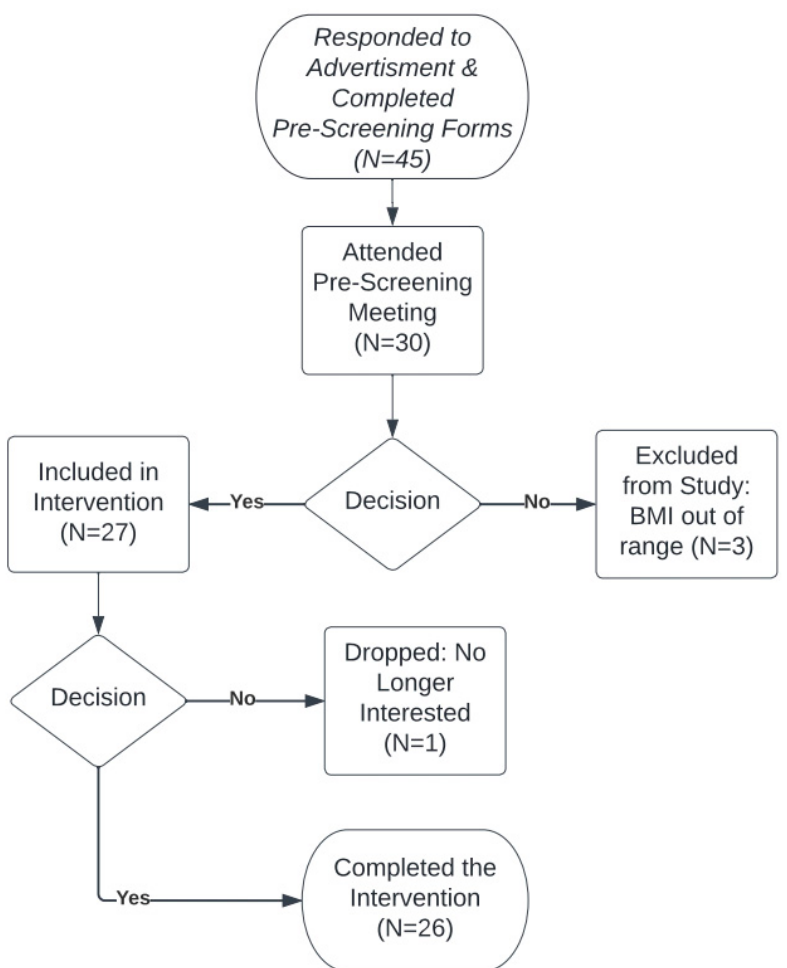
Figure 2. Design of the diet and exercise intervention. Flowchart illustrates the steps of the interven- tion and number of participants completed each step. Total of 45 subjects were intended to participate but only 26 subjects completed the intervention. Blood samples were collected from 27 subjects and used in pre-intervention miR analysis, and post microRNA was analyzed from 26 subjects who successfully completed the intervention.